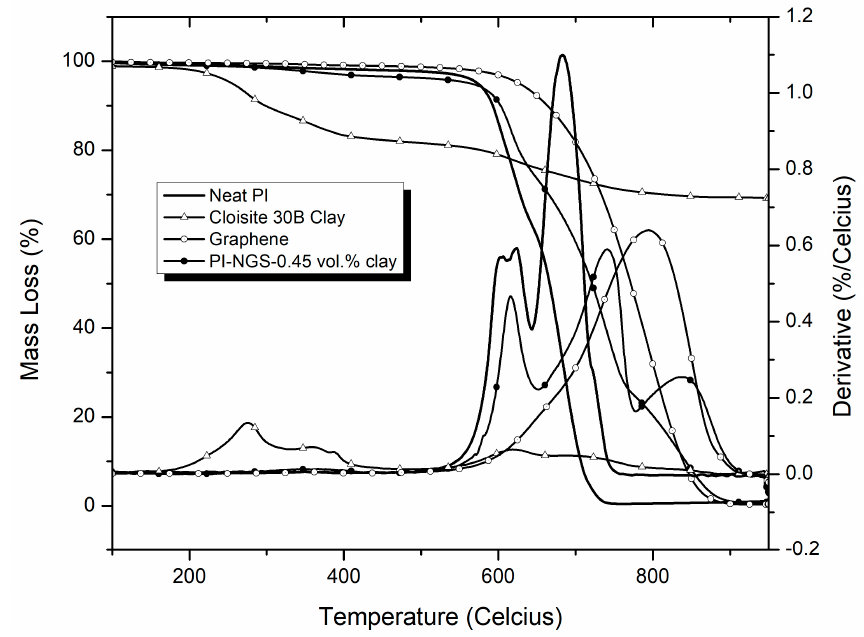
Figure 6. Graph showing the TGA degradation profiles for polyimide, Cloisite 30B organomodified clay, graphene, and PI-NGS-0.45 vol.% clay in air at a heating rate of 30 ◦